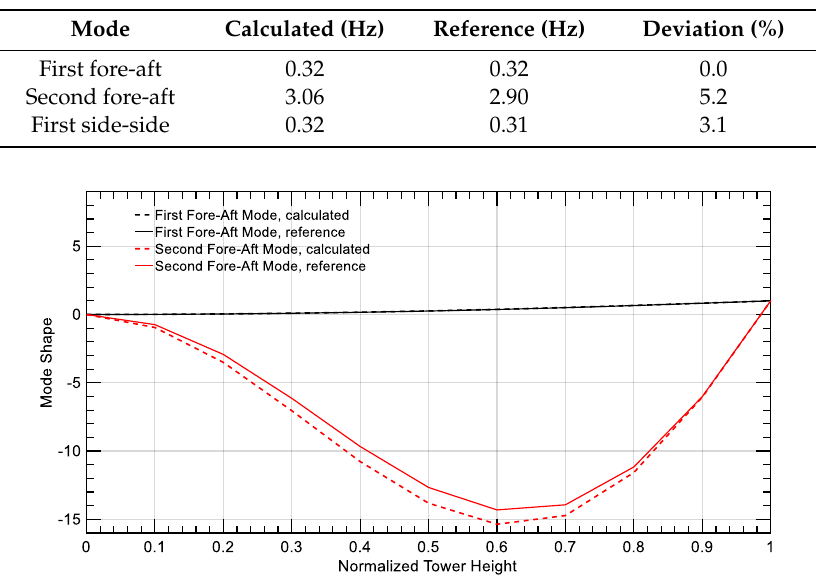
Figure 8. Tower fore-aft mode shapes: single rotor configuration.